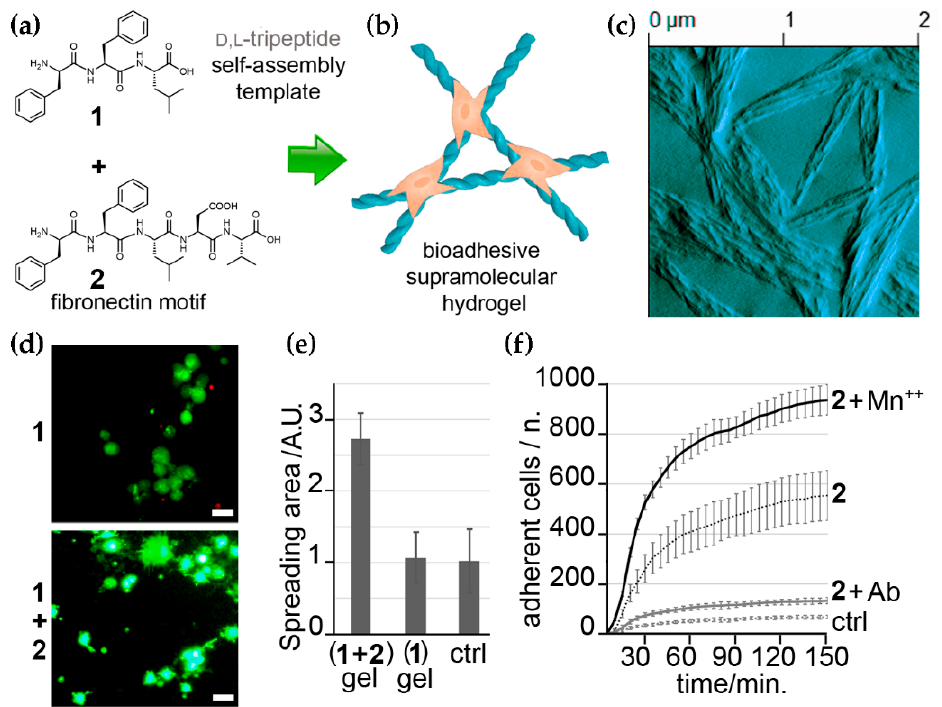
Figure 3. ( a ) Chemical structures of two self-assembling short peptides with structural (1) and bioactive (2) roles for the co-assembly into bioadhesive hydrogels ( b ). ( c ) AFM image of the co-assembled gel. ( d ) live-dead cell-microscopy images of the control (1) and the bioadhesive (1 + 2) hydrogels with fibroblasts. ( e ) Quantification of cell spreading. ( f ) Adherent cells’ count in the presence of Mn ++ and a β 1 integrin-blocking antibody (Ab) demonstrates integrin engagement for cell adhesion on the biomaterial and successful ECM mimicry. Adapted from [75].